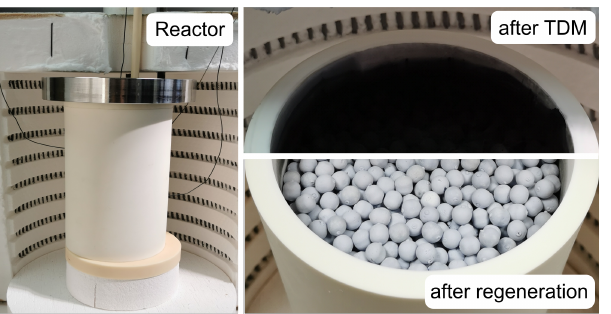
Figure 2. Outer view of the reactor ( left ) and view in the reactor: after a thermal decomposition of methane (TDM) measurement at 1300K ( upper right ) and after the steam regeneration ( lower right